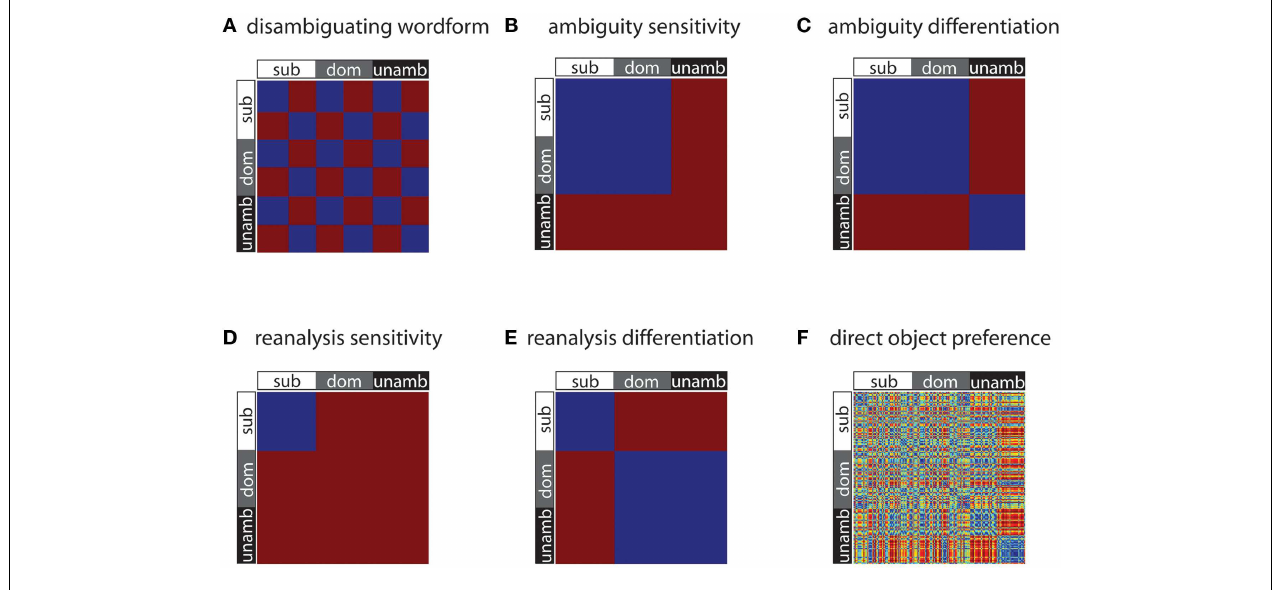
similarity across stimuli – for wordform (A) , syntactic ambiguity (B, C) , and syntactic reanalysis (D, E) . Note that direct object preference (F) is a continuous-valued measure, and so dissimilarities based on object preference take on a range of values, from 0 to